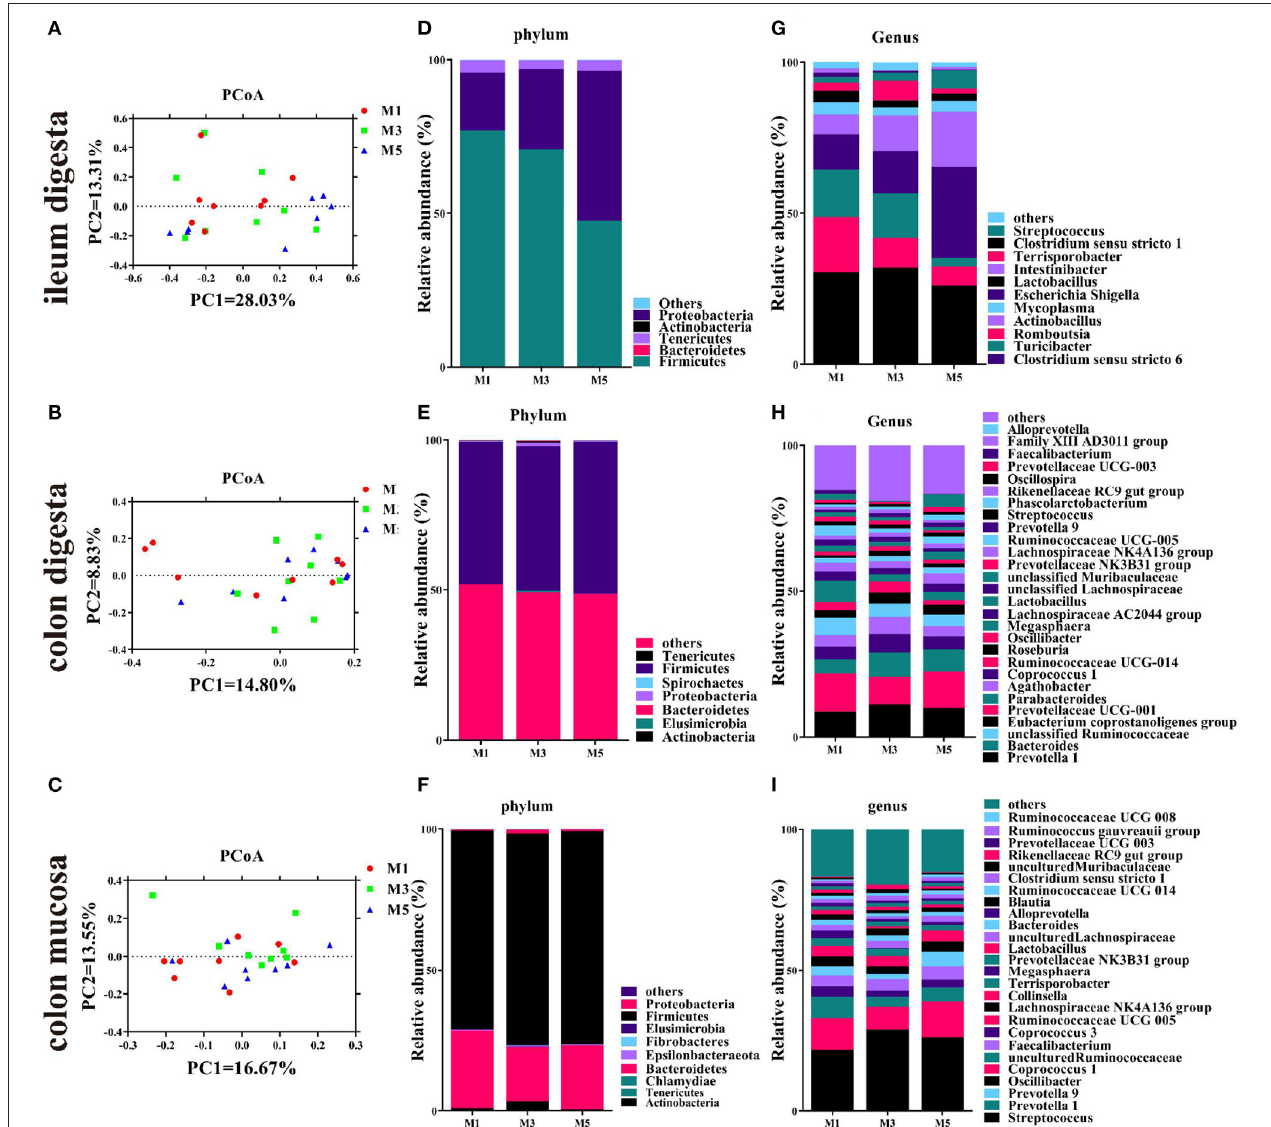
FIGURE 2 | Effect of feeding frequency on intestinal microbiota of pigs. Unweighted unifrac principal coordinates analysis (PCoA) plot of ileal digesta microbiota (A) , colonic digesta microbiota (B) , and colon mucosa microbiota (C) ( n = 8). Bacterial community of ileal digesta (D) , colonic digesta (E) , and colon mucosa (F) at the phylum level. Bacterial community of ileal digesta (G) , colonic digesta (H) , and colon mucosa (I) at the genus level (abundance > 1%). M1, one meal per day; M3, three meals per day; M5, five meals per